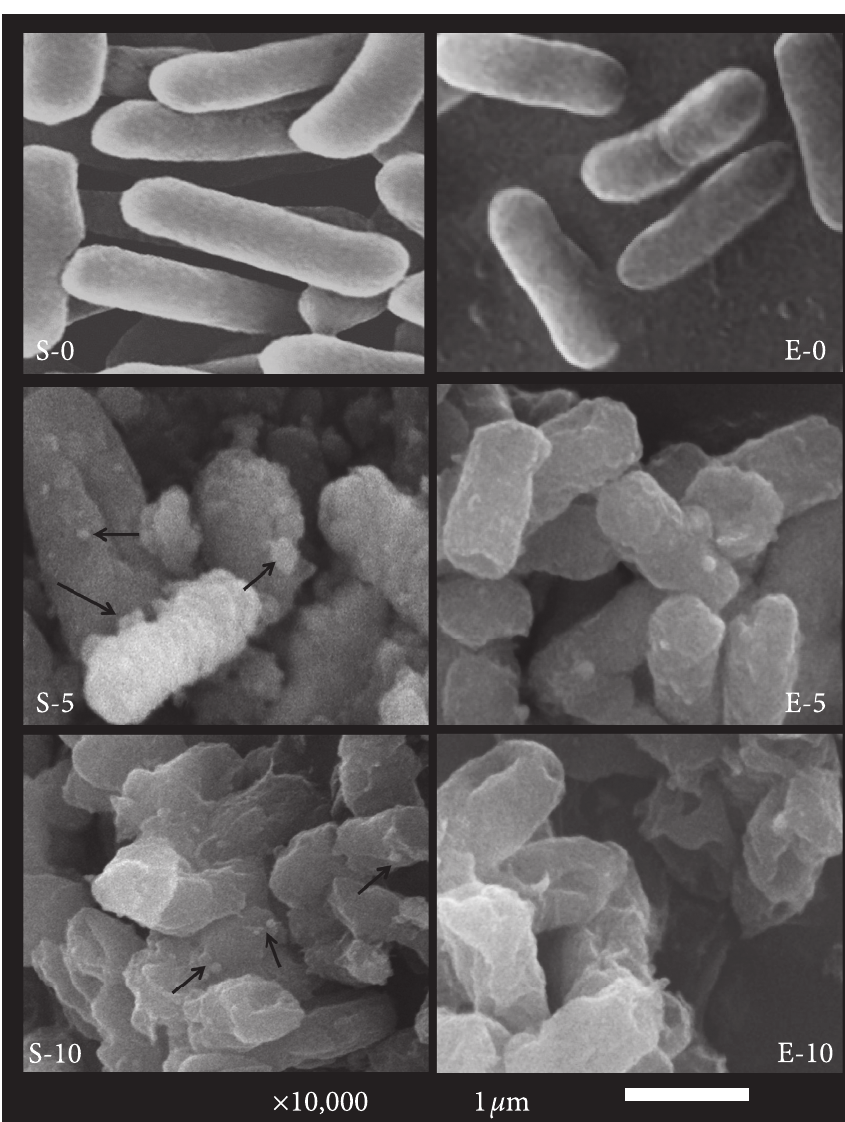
Figure 5: SEM micrographs of exposed Salmonella typhimurium (S) and E. coli (E) to phytosynthesized Se-NPs with cinnamon bark extract after 0, 5, and 10 h of treatment. Arrows indicate the some attached Se-NPs to compromised bacterial